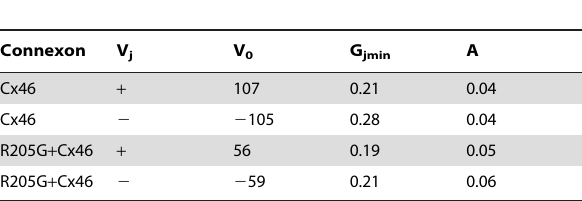
Table 1. Boltzmann parameters for homomeric Cx46 and heteromeric Cx46/Cx50-R205G